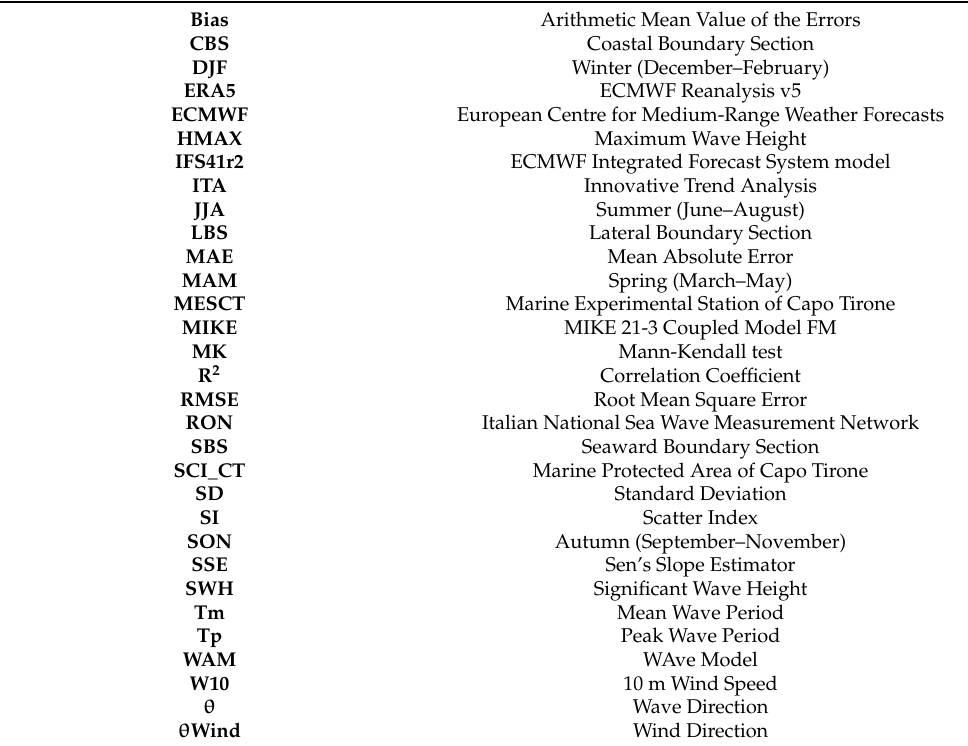
Table A1. List of acronyms used in this work (alphabetical